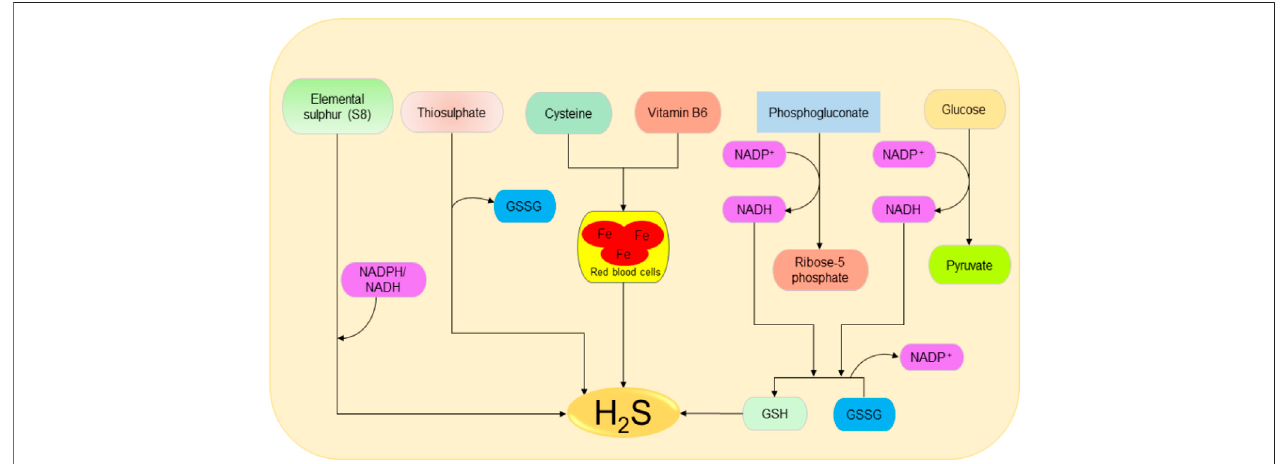
FIGURE2| Possiblespontaneous/nonenzymatic pathwaysinvolvedintheproductionofH 2 Sfromelementalsulfur,thiosulfate,glutathione,cysteine,glucose,and phosphogluconate.Startingfromtheright-handside,thetwoprocessesofglycolysisandNADPHoxidasefacilitatethereductionofGSSGtoGSH,whichcanbedirectly reduced to H 2 S. Next, in the presence of vitamin B6, cysteine can be catalyzed by iron contained in the red blood cells to produce H 2 S. Thiosulfate and elemental sulfur can also be reduced to H 2 S. H 2 S, hydrogen sul fi de; NADPH, nicotinamide adenine dinucleotide phosphate oxidase; GSSG, oxidized glutathione; GSH, reduced glutathione.